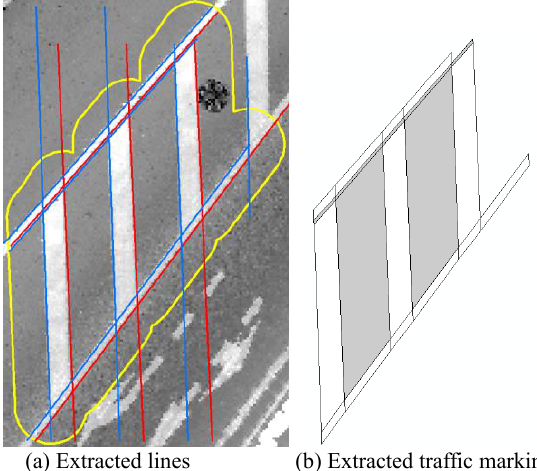
Figure 13. Result of local changing points and extracted lines by the proposed method